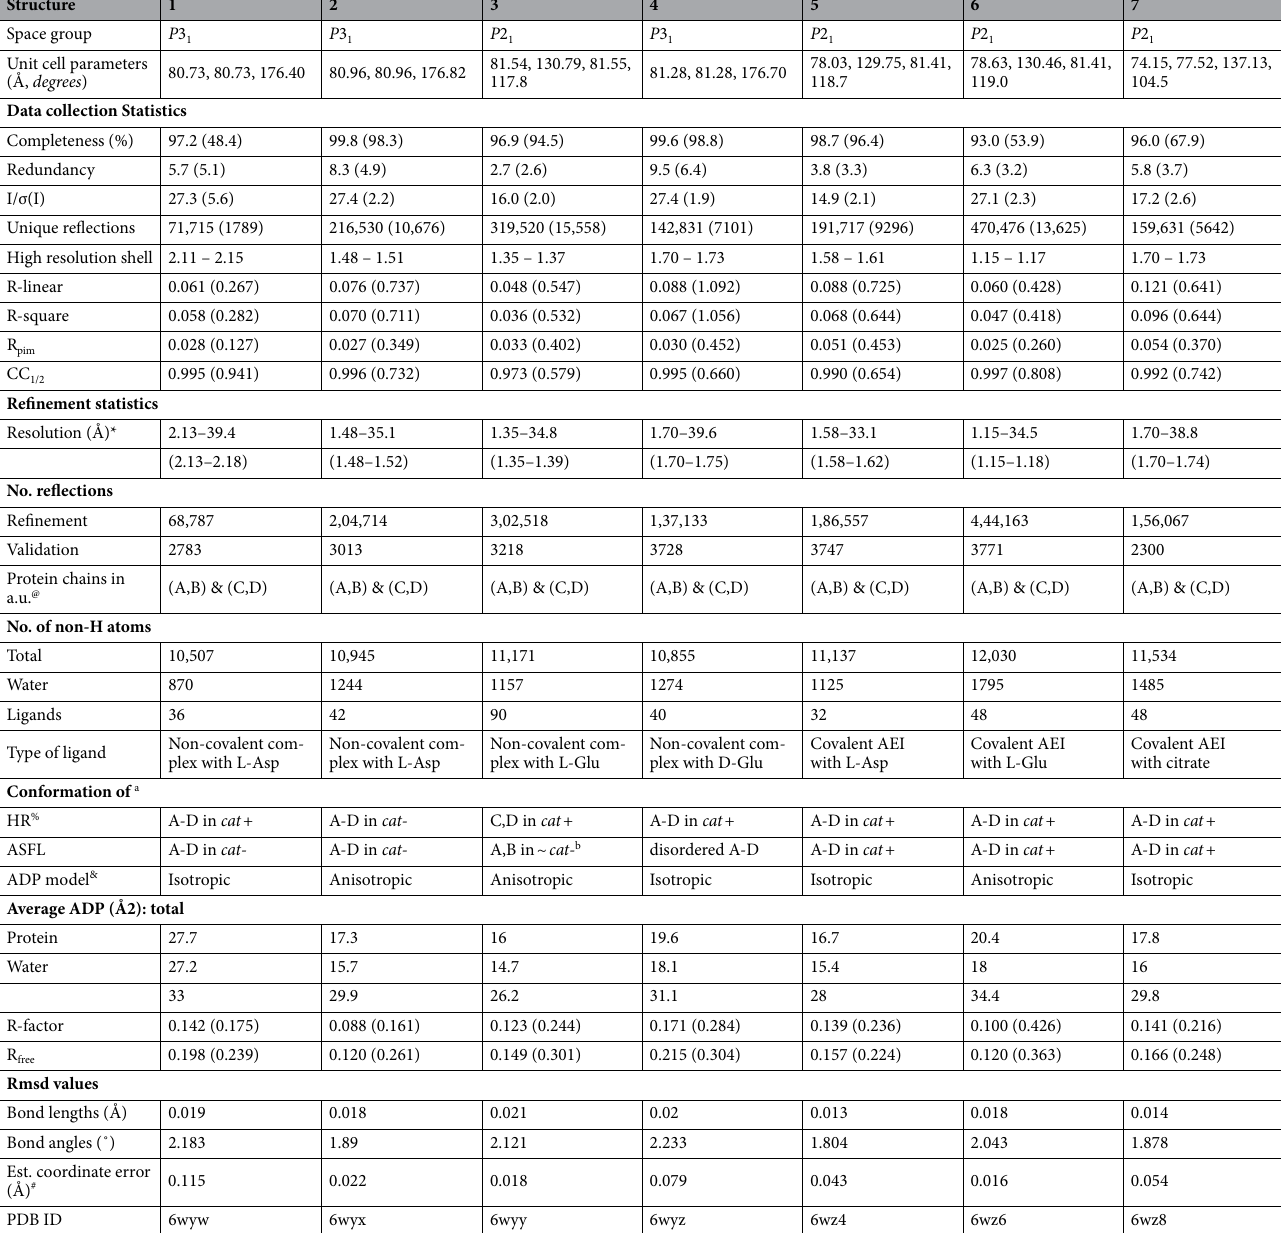
Table 2. Statistics of data collection and structure refinement. *Numbers in parentheses refer to the high- resolution shell. & ADP, atomic displacement parameters. # Estimate based on maximum likelihood. @